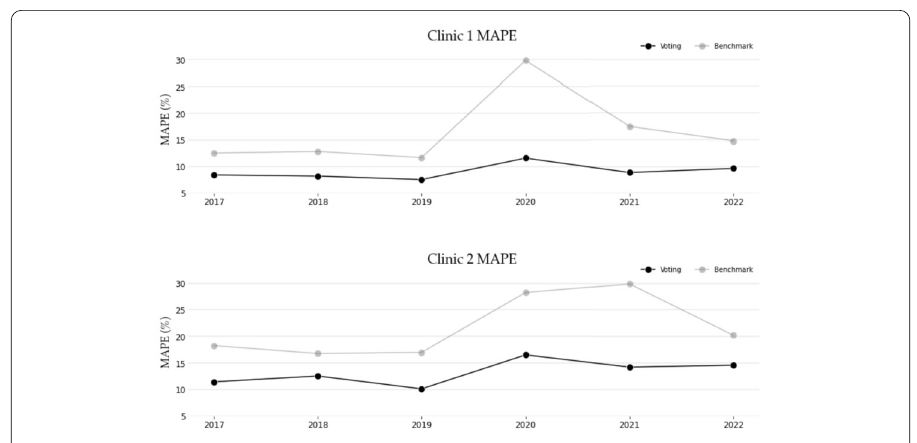
Figure 6 Comparison of MAPE accuracies between the benchmark and Voting models across both clinics and all the